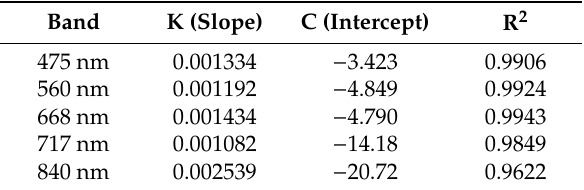
Table 5. Radiometric calibration coefficients of the multispectral camera.